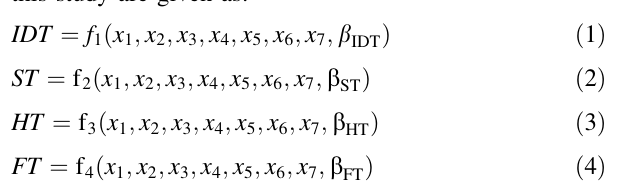
O , (3) x 3 : weight per- 2 3 O ? Na 2 2